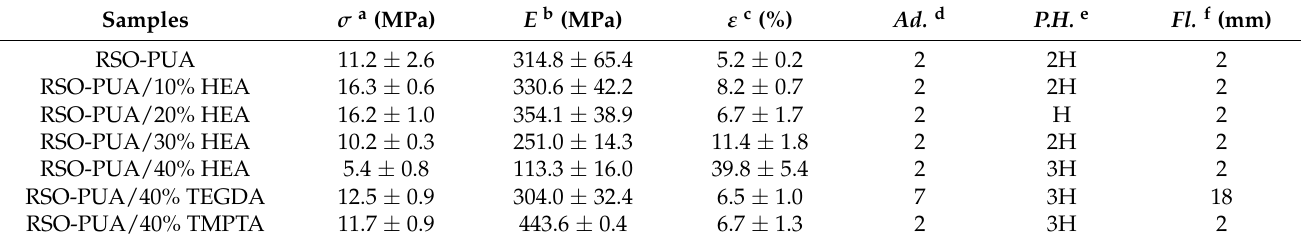
Figure 5. Tensile stress − strain curves of the UV-cured RSO-PUA resins. Table 3. Mechanical properties and coating properties of the cured RSO-PUA